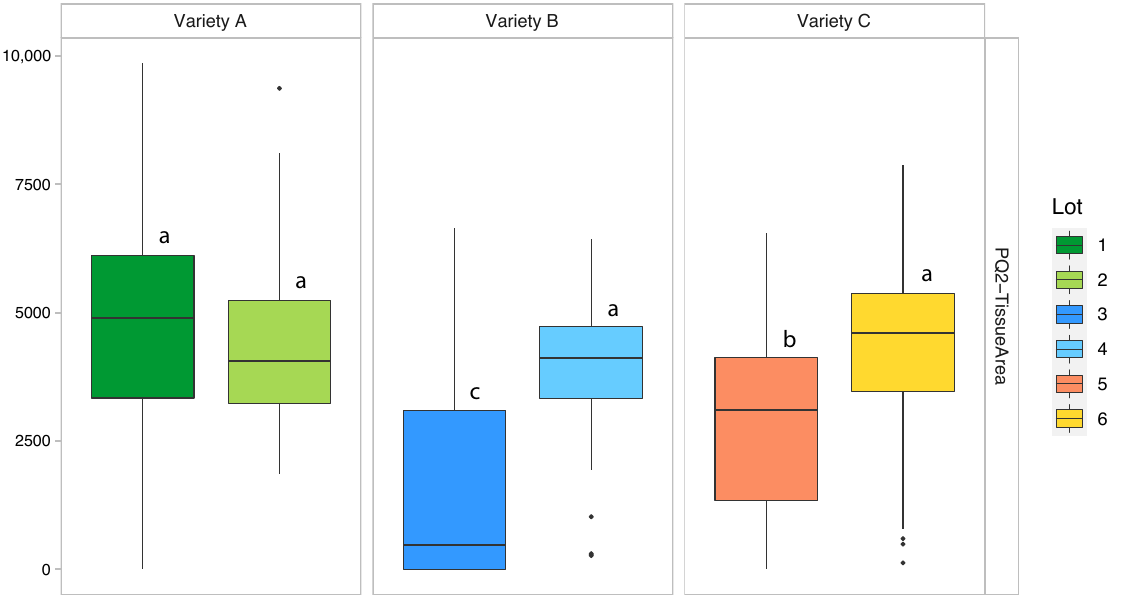
Figure 9. Seedling area (in pixels) of induced seeds after seed respiration measurements and before transfer to the greenhouse for plant growth and evaluation. Letters indicate significance difference among all lots as calculated by ANOVA and Tukey